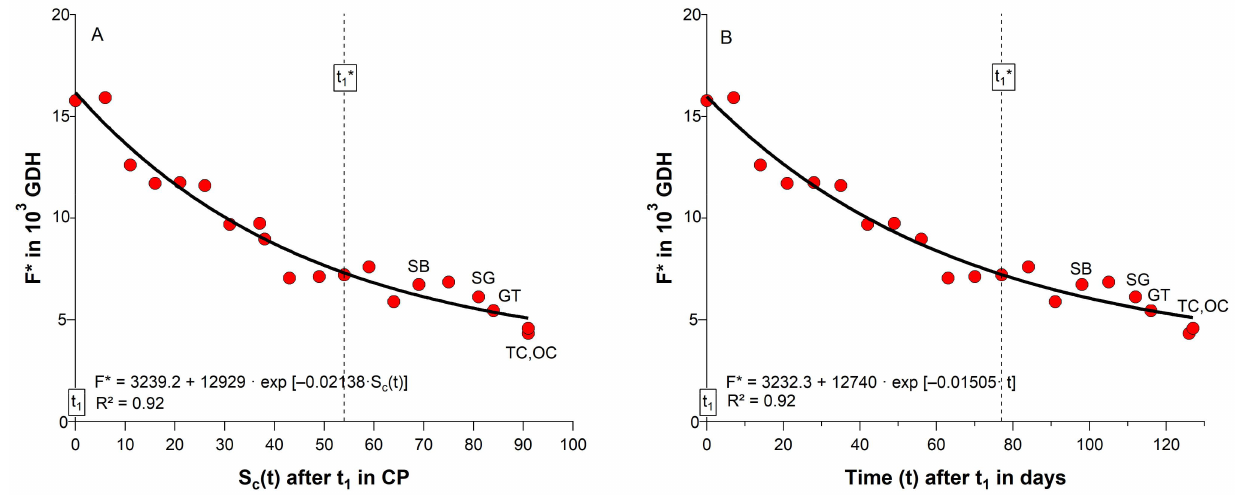
Figure 2. Relationship between forcing requirement until cherry blossom (F* in GDH) and ( A ) chill accumulation until sampling (S c (t) in CP), as well as ( B ) time after t 1 in days, for cherry buds under controlled conditions ( ∼ 24 ◦ C, 12 h light, 70% relative humidity) between t 1 and ‘tight/open cluster’ (TC, OC), 2018/19 season. t 1 : endodormancy release, t 1 *: beginning of ontogenetic development, SB: ‘swollen bud’, SG: ‘side green’, GT: ‘green tip’, R 2 : coefficient of